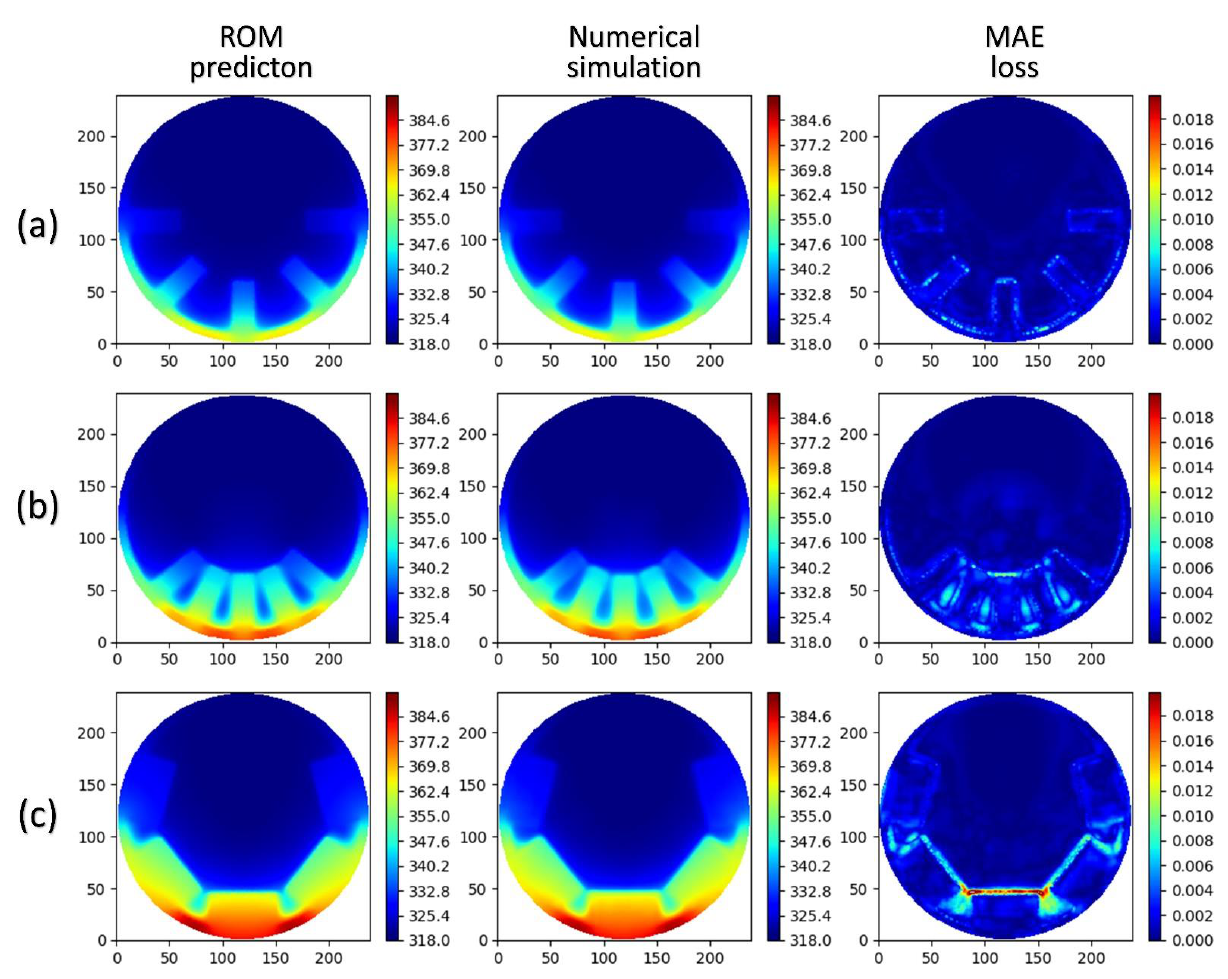
Figure 9. Temperature field predictions of three representatives with various fin heights, widths, and positions: ( a ) [ h, w, α ] = [12 mm, 5 mm, 45°]; ( b ) [ h, w, α ] = [12 mm, 6 mm, 18°]; ( c ) [ h, w, α ] = [10 mm, 21 mm, 52°].